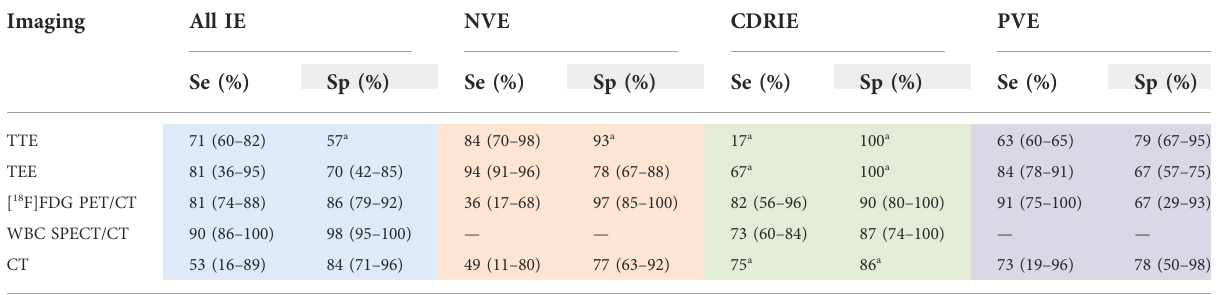
TABLE 2 Diagnostic accuracy with reported sensitivity and speci fi city of various imaging modalities.